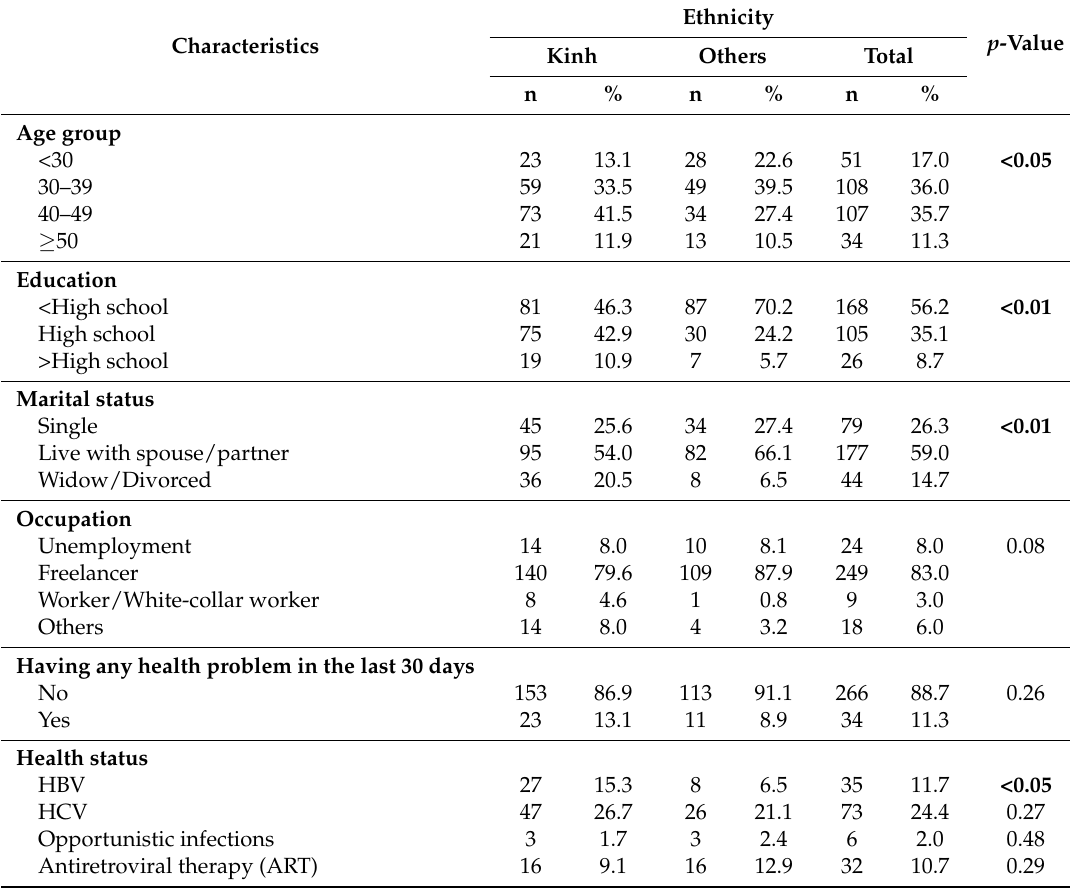
Table 1. Demographic characteristics of